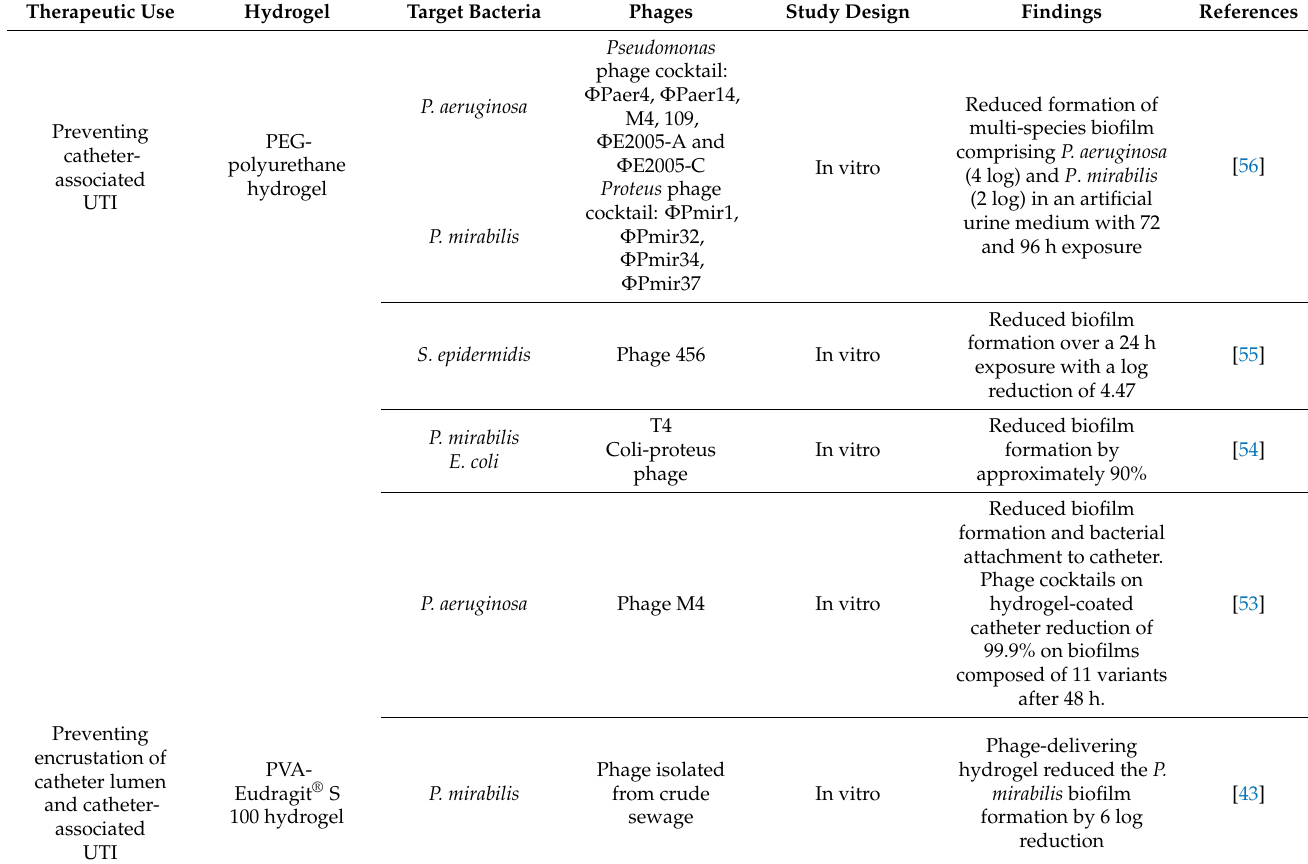
Table 3. Summary of phage-delivering hydrogels in catheter-associated urinary tract